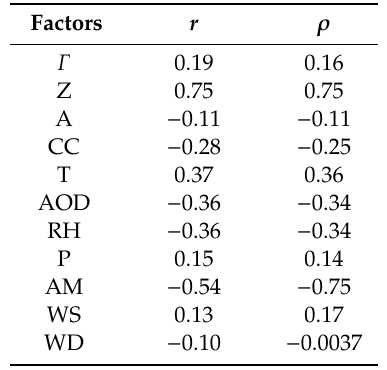
Figure 1. Structure of the proposed ensemble model for global horizontal irradiance (GHI) forecast. Table 1. Correlation coefficients for GHI and different factors.